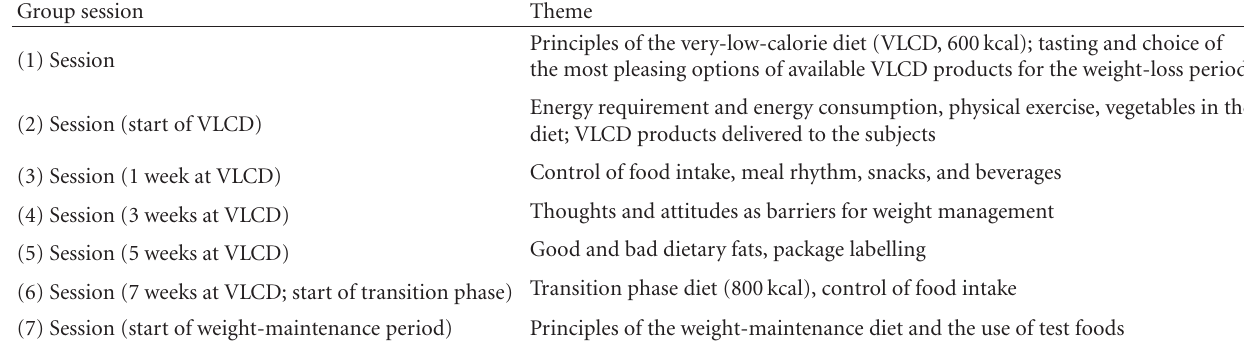
Table 3: The themes discussed in the group sessions during the weight-loss period. Group session Theme